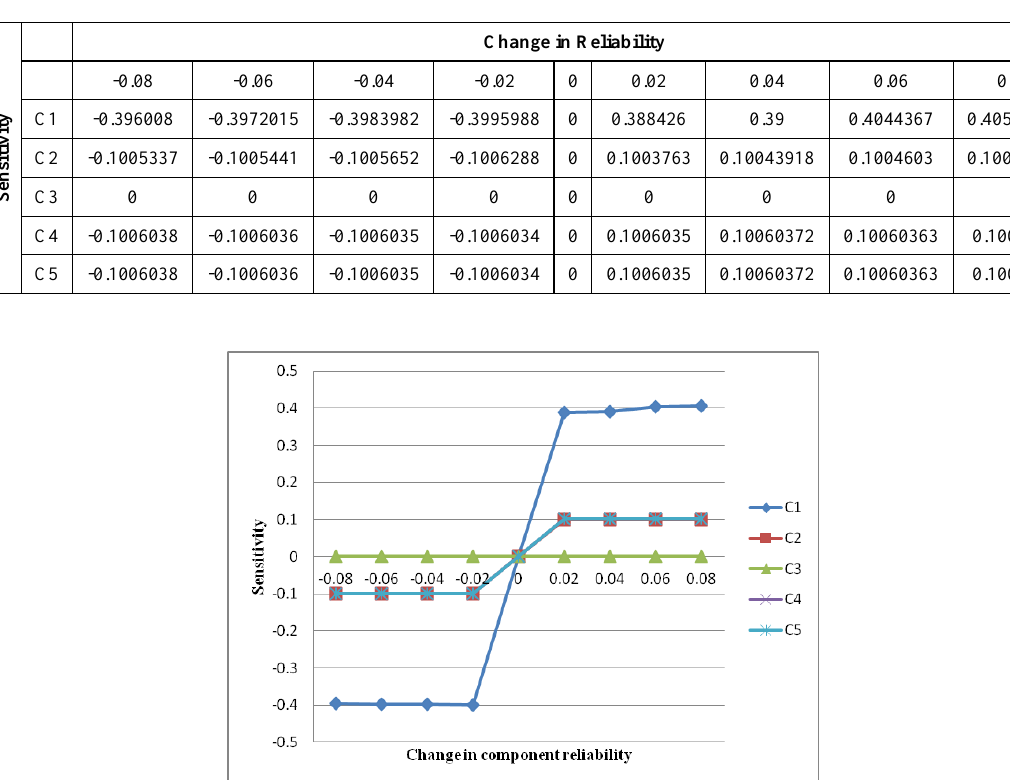
Table 3. Sensitivity analysis (Scenario 1)